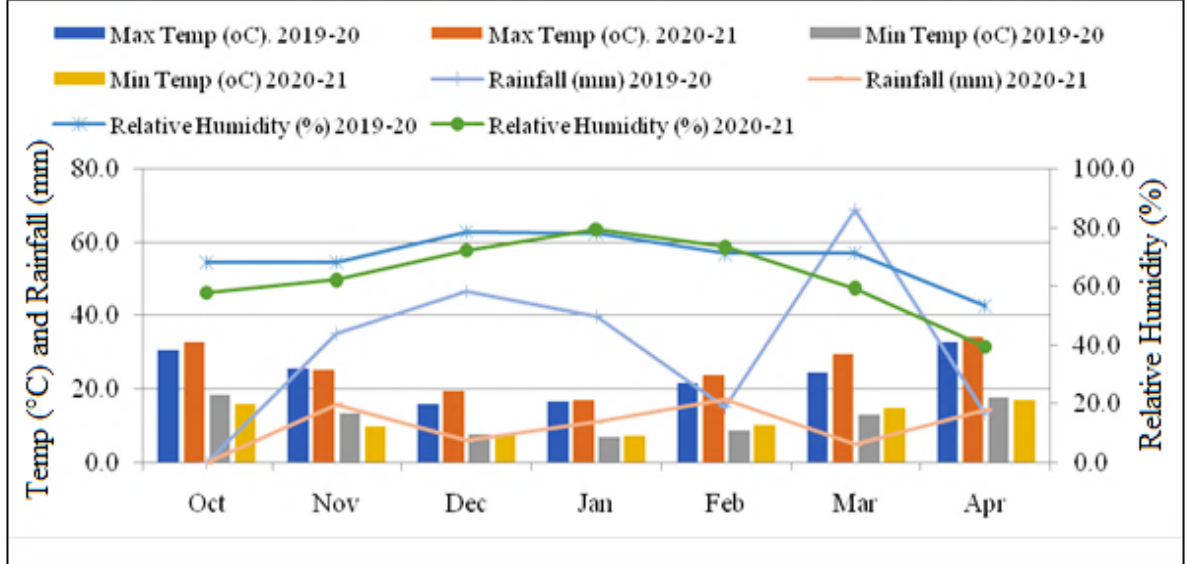
Figure 1. Monthly average maximum and minimum temperature, relative humidity and rainfall of the experimental area. The soil of the experimental area was sandy loam with a pH of 7.23, EC = 0.33 dS m − 1 , and the soil organic carbon content was 0.34%. The initial levels of micronutrients, viz.